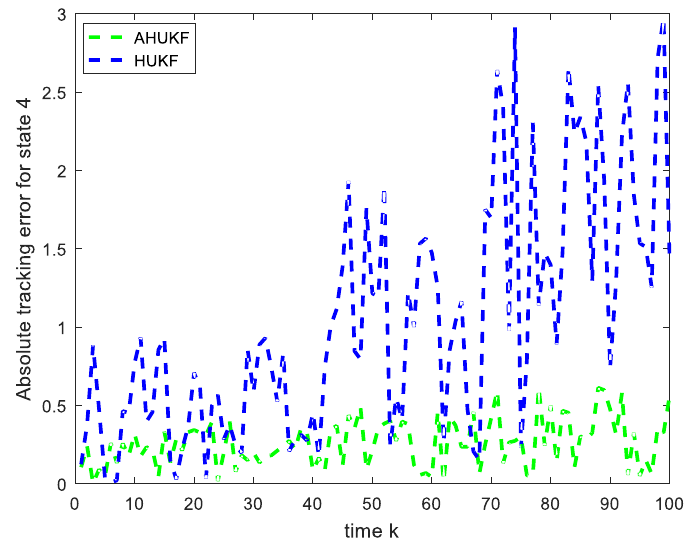
Figure 5. Tracking error curve for State 4. Table 1. Comparison of RMSE for four states.